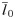
The influence of senescent mortality on the relationship between l¯0 and e0 (in years) when overall mortality rates are bathtub-shaped.Shown are data points calculated from mortality trajectories where a0 = 0.5, a1 = 0.778, and c = 0. (a) The effect of the level of senescent mortality (b0). (b) The effect of the rate of senescent mortality (b1).